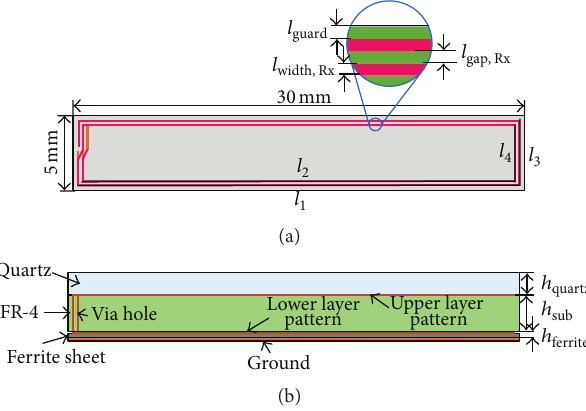
Figure 5: Geometry of the designed Rx resonant coil: (a) top and (b)